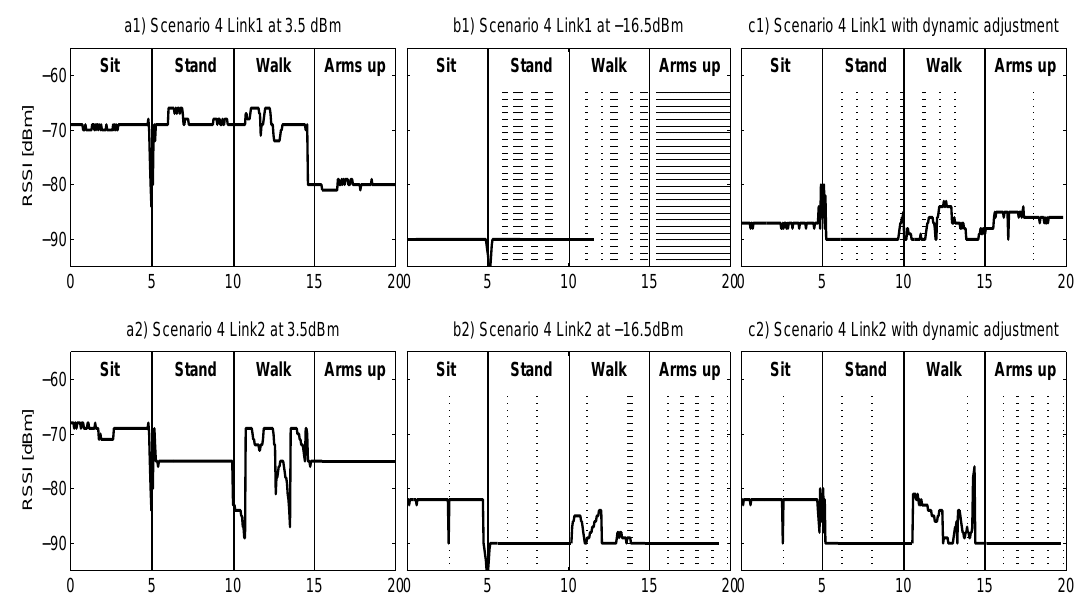
Figure 13. RSSI evolution for Samsi in Scenario